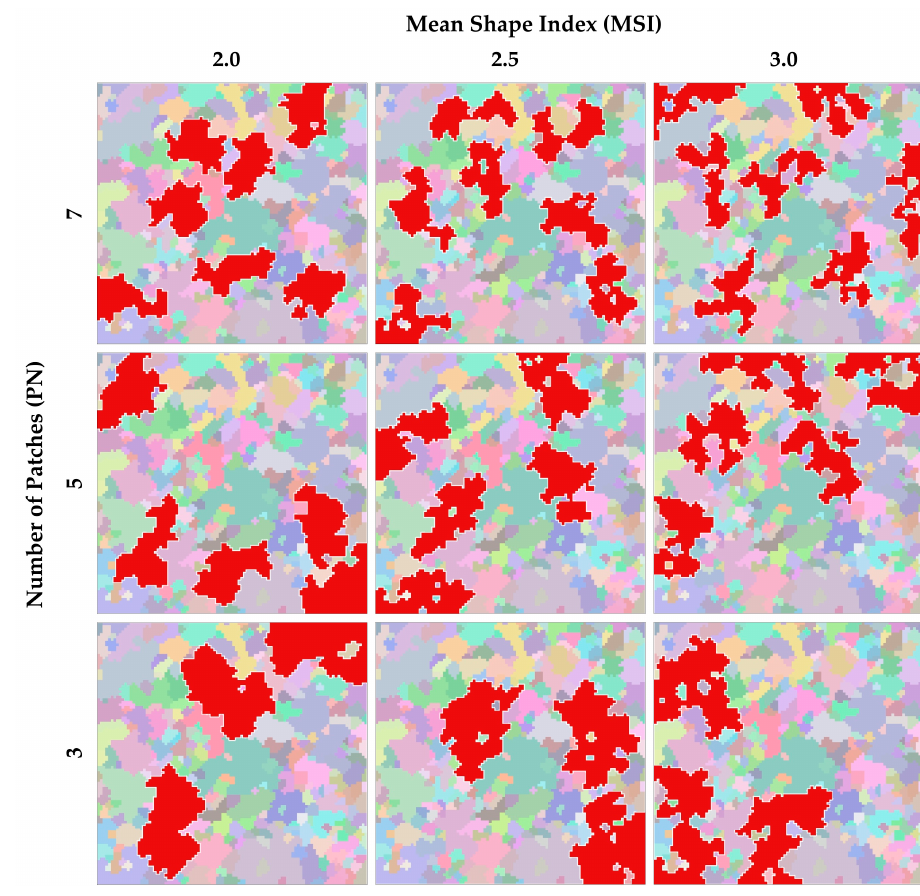
Figure 11. The generated landscapes with different PNs and MSIs.